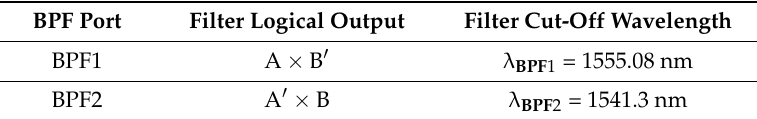
Table 1. The cut-off wavelengths for BPF1 and BPF2.